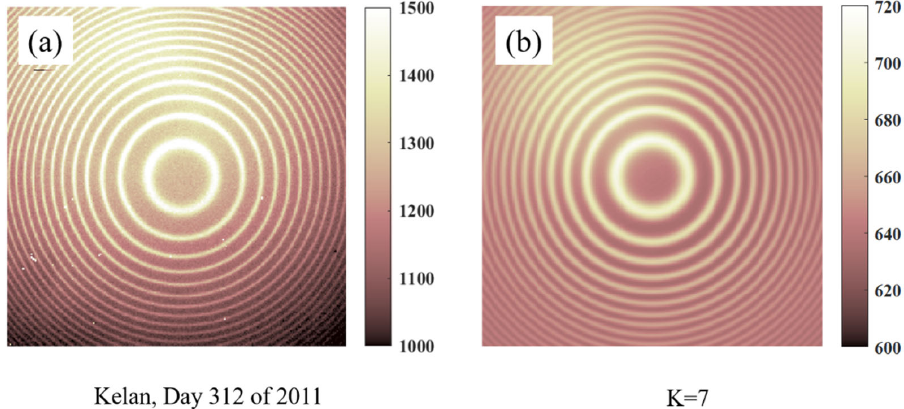
Figure 8. ( a ) Distorted FPI airglow interferogram (Kelan, Day 312 of 2011) and ( b ) simulated distortion interferogram ( K = 0.1).